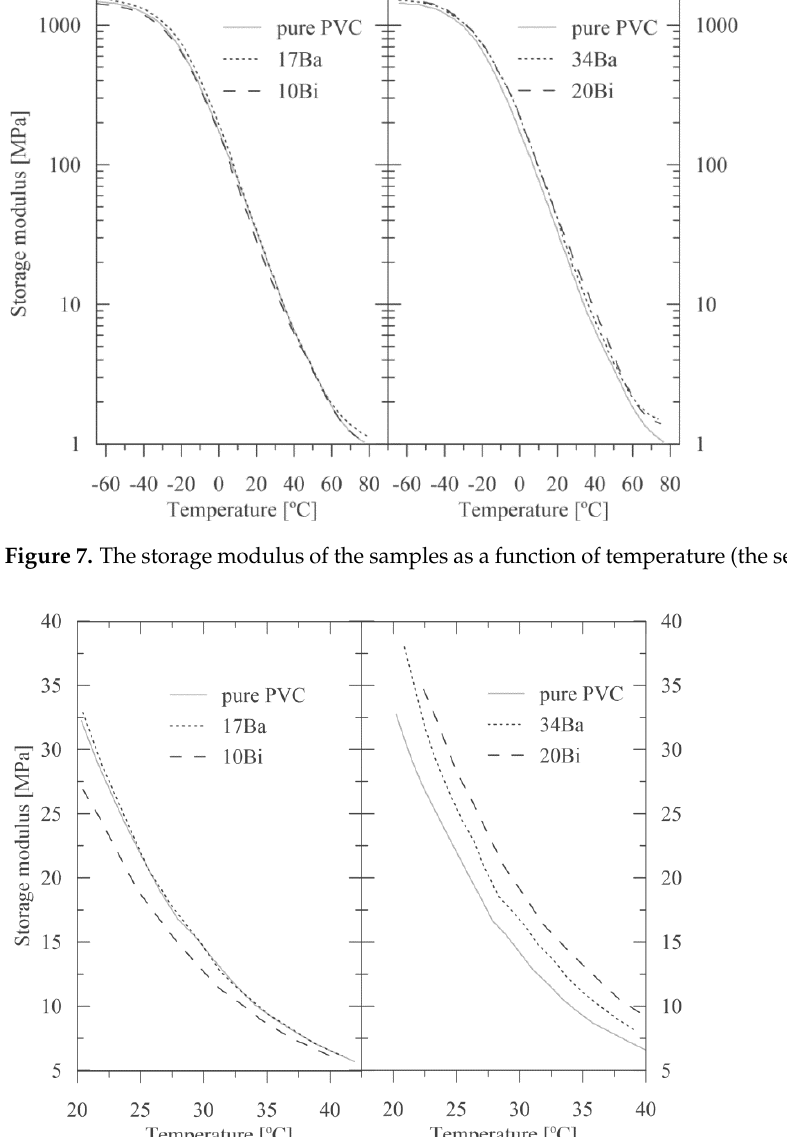
Figure 8. The storage modulus of the samples as a function of temperature—a detail in the normal coordinates.